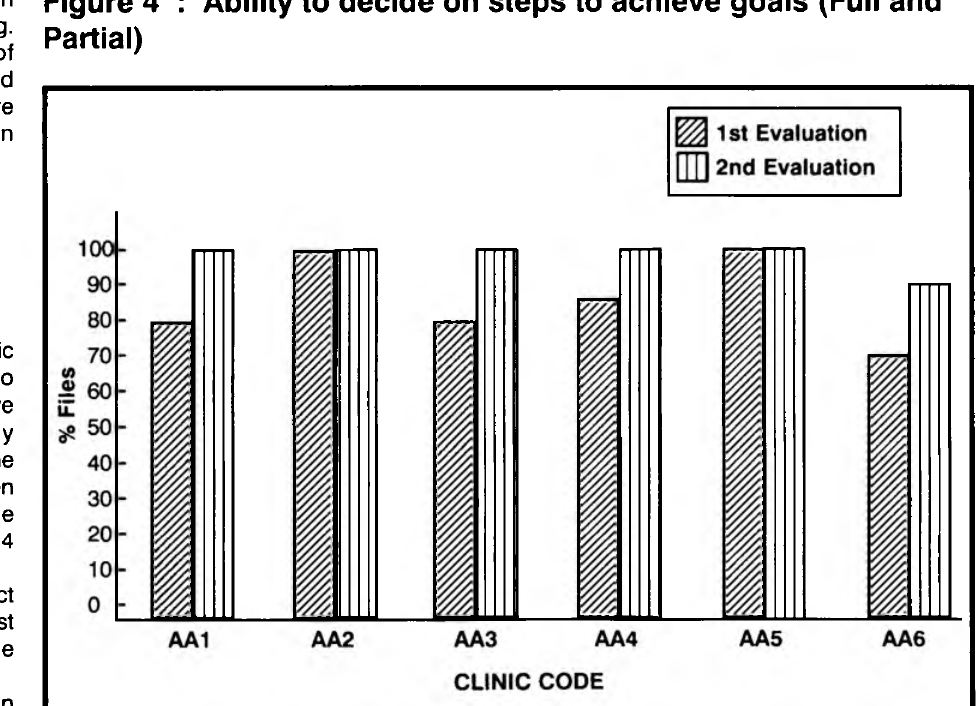
Figure 4 : Ability to decide on steps to achieve goals (Full and